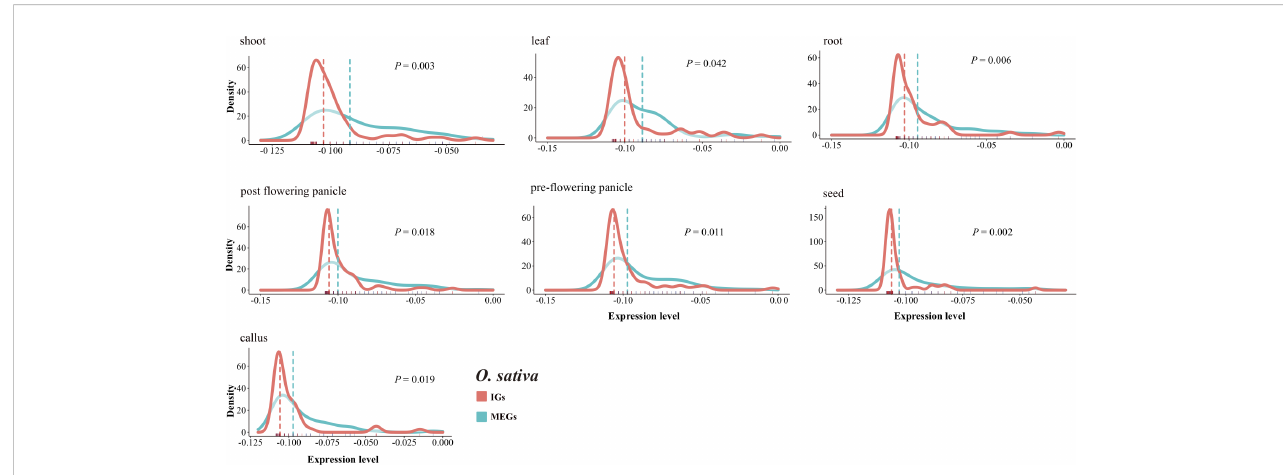
FIGURE 8 Comparison of the IG and MEG expression levels in rice tissues. The dotted line represents the median normalized expression level. The rug on the horizontal axis shows the density. The P -value for a two-sided paired Wilcoxon sign test is